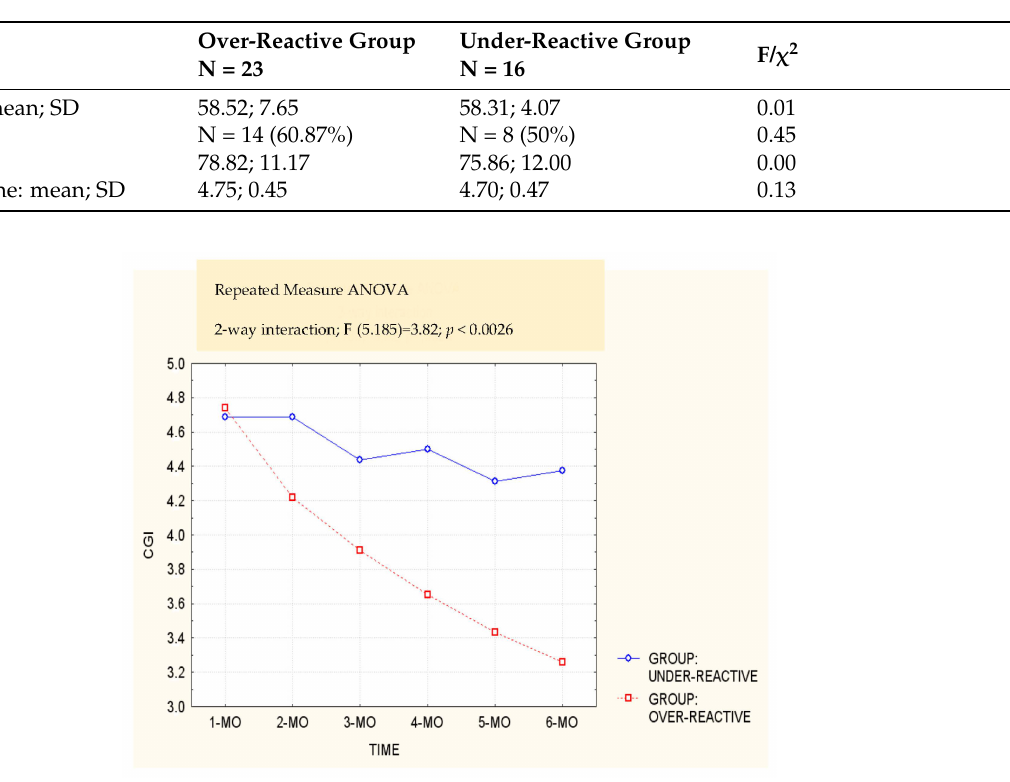
Table 1. Characteristics of the samples (over-reactive vs. under-reactive groups).